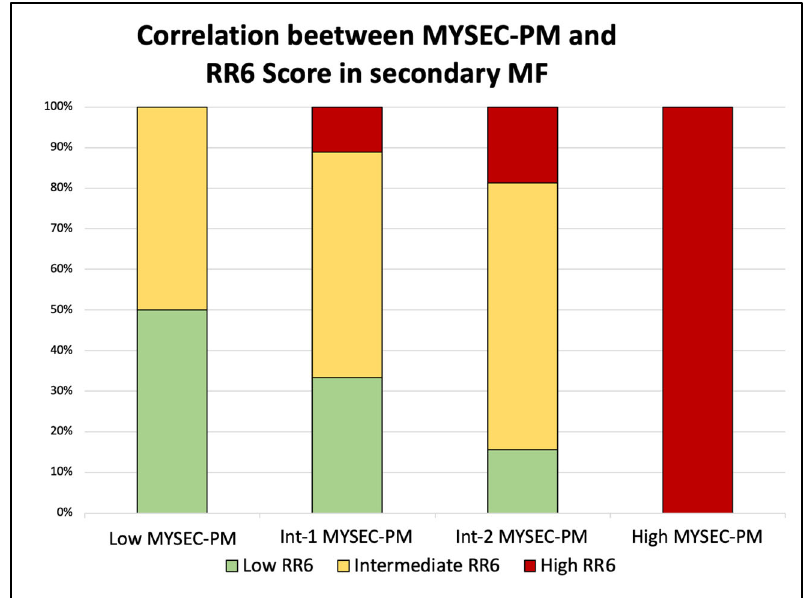
Figure 3. Correlation between RR6 and MYSEC ‐ PM risk classes in the context of secondary myelo ‐ fibrosis.